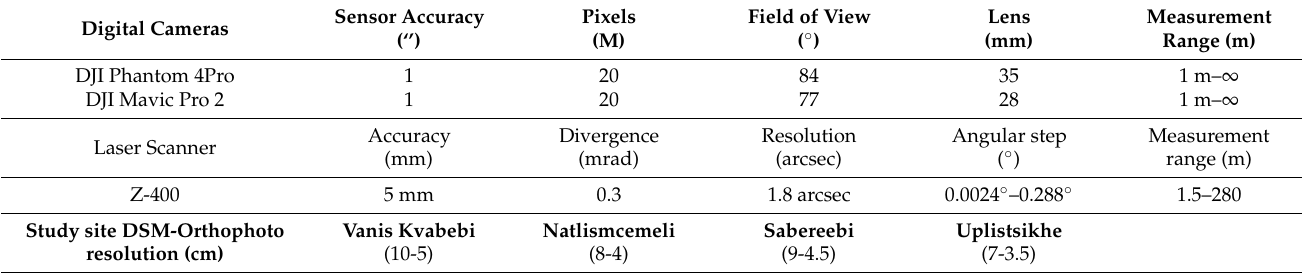
Table 2. Technical information of the adopted devices and the obtained DSMs resolutions. Digital